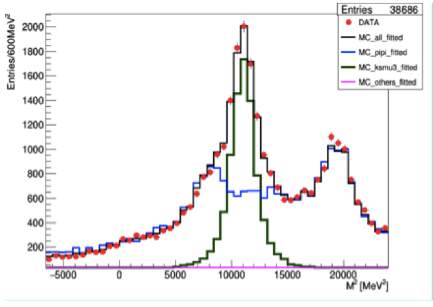
Figure 5. Invariant mass squared the lepton (in the muon hypothesis) in K S µ 3 semileptonic decays.